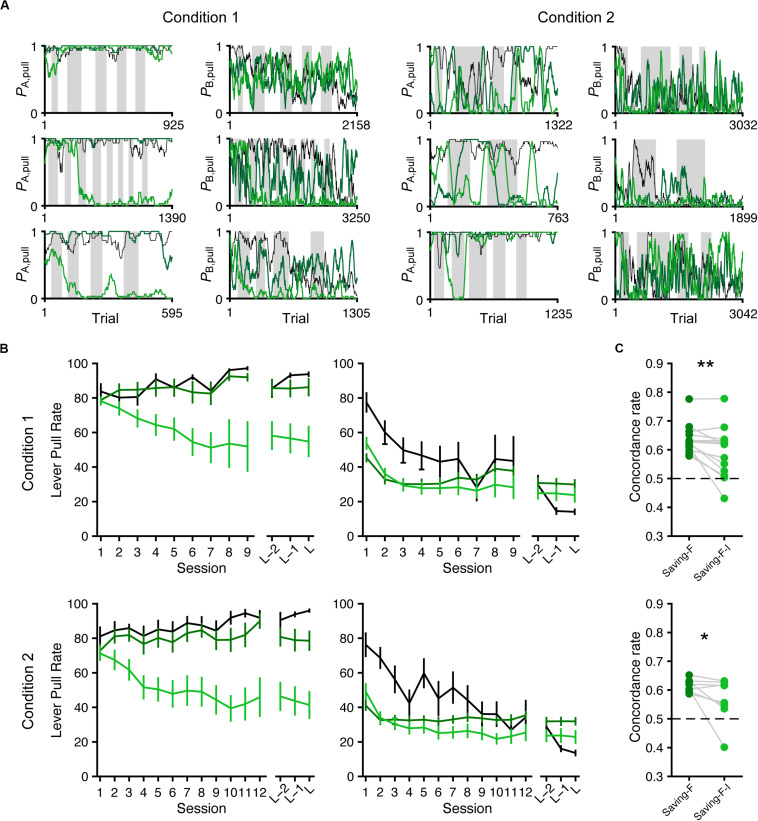
Simulated lever-pull choice behavior with the saving-F and saving-F-I models. (A) Six representative simulated pull-choice probabilities with the saving-F (dark green) and saving-F-I (light green) models in tone A (leftmost and second right) and B (second left and rightmost) trials in conditions 1 (leftmost and second left) and 2 (second right and rightmost). Traces represent the 30-trial moving-average of the actual (black) or simulated pull-choice. Even sessions are shaded. (B) Mouse-averaged actual (black) and simulated (saving-F model, dark green; saving-F-I model, light green) lever-pull rates in tone A (left) and B (right) trials in conditions 1 (top; n = 13 mice) and 2 (bottom; n = 8 mice). L indicates the last session. (C) The proportion of trials in which the simulated pull/non-pull-choice was the same as the actual pull/non-pull-choice (“concordance rate”) in conditions 1 (top) and 2 (bottom). Each line indicates a single mouse. For each mouse, the concordance rate was calculated for each simulation and averaged over the 1000 simulations. *p = 0.0391, **p = 0.00610.